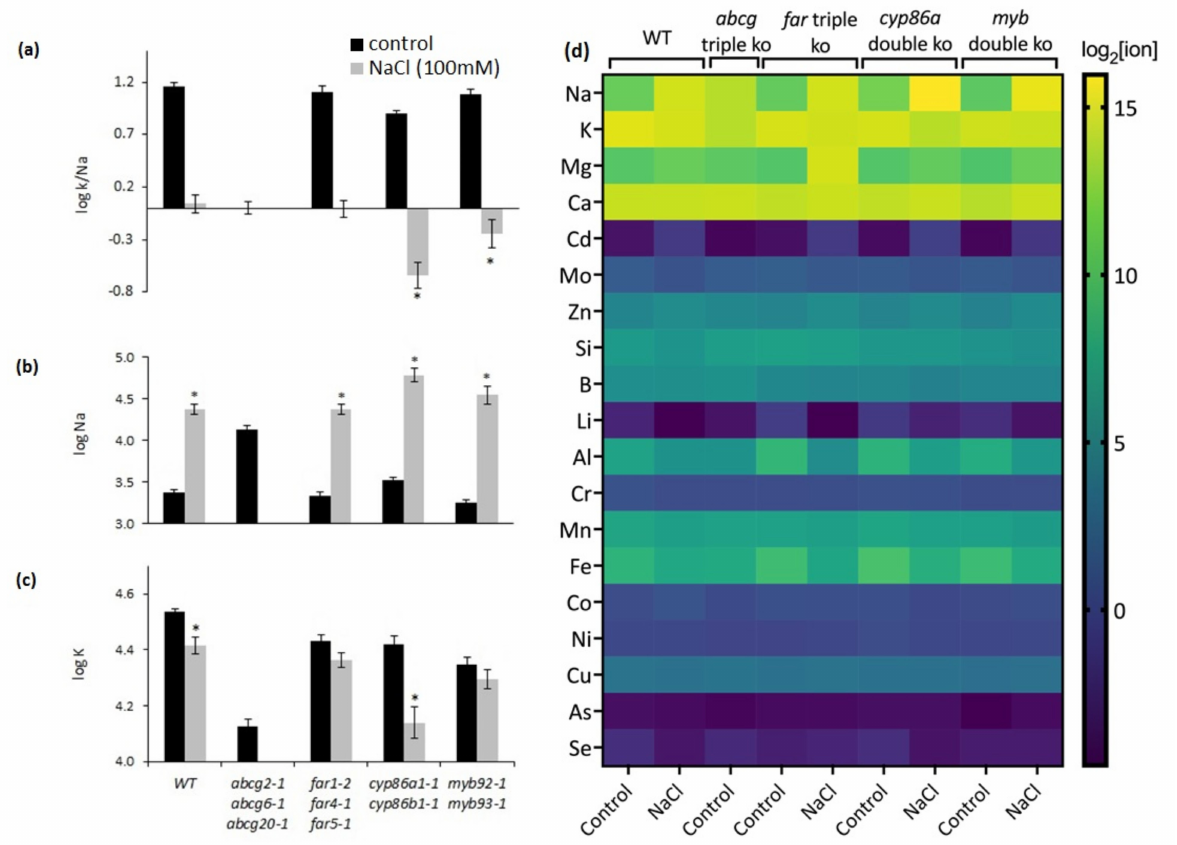
Figure 9. Analysis of elements in leaf tissues of wild type and mutants under control and NaCl treatment. ( a ) log K/Na, ( b ) log Na, ( c ) log K. ( d ) Analysis of elements (left) in leaf tissues. The heat map represents the abundance of each analyzed element (Table S4) as log 2 of each element concentration given in parts per million (ppm) under control (0 mM NaCl) and 100 mM NaCl treatments. For each element, data are derived from 4–5 plants. Abcg2-1 abcg6-1 abcg20-1 NaCl treatment data are not included in the figure and statistical analysis due to salt hypersensitivity. Mean values in ( a – c ) are from 4 replicate samples ± SE. Each replicate represents a pool of 4–5 leaves from an individual plant. In ( a ), Asterisks indicate the differences at p < 0.05 by Student’s t -test comparing NaCl-treated wild-type and NaCl-treated mutant plants. In ( b , c ), asterisks indicate the differences at p < 0.05 by Student’s t -test comparing the control and NaCl treatment. ANOVA results indicated significant interactions between genotype and treatment effects in leaf Na at p < 0.05 and leaf K at p < 0.01 (Table